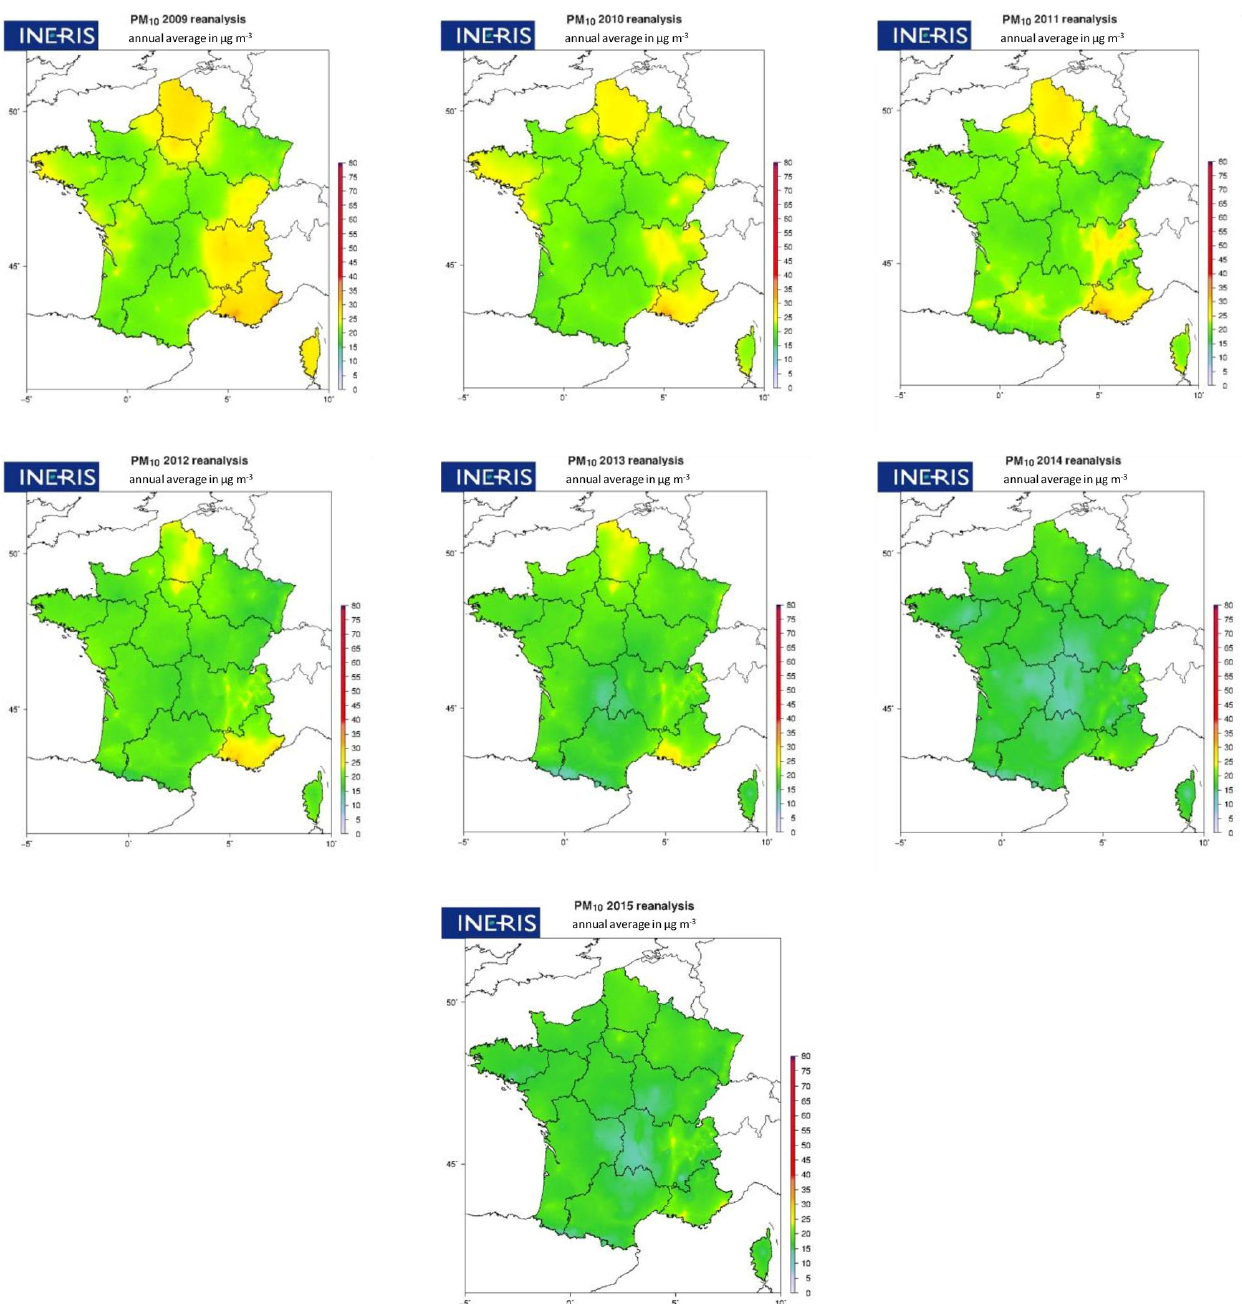
Figure 9. PM 10 annual mean concentrations from 2000 to 2015. Concentrations are obtained through a combination of regional modeling and